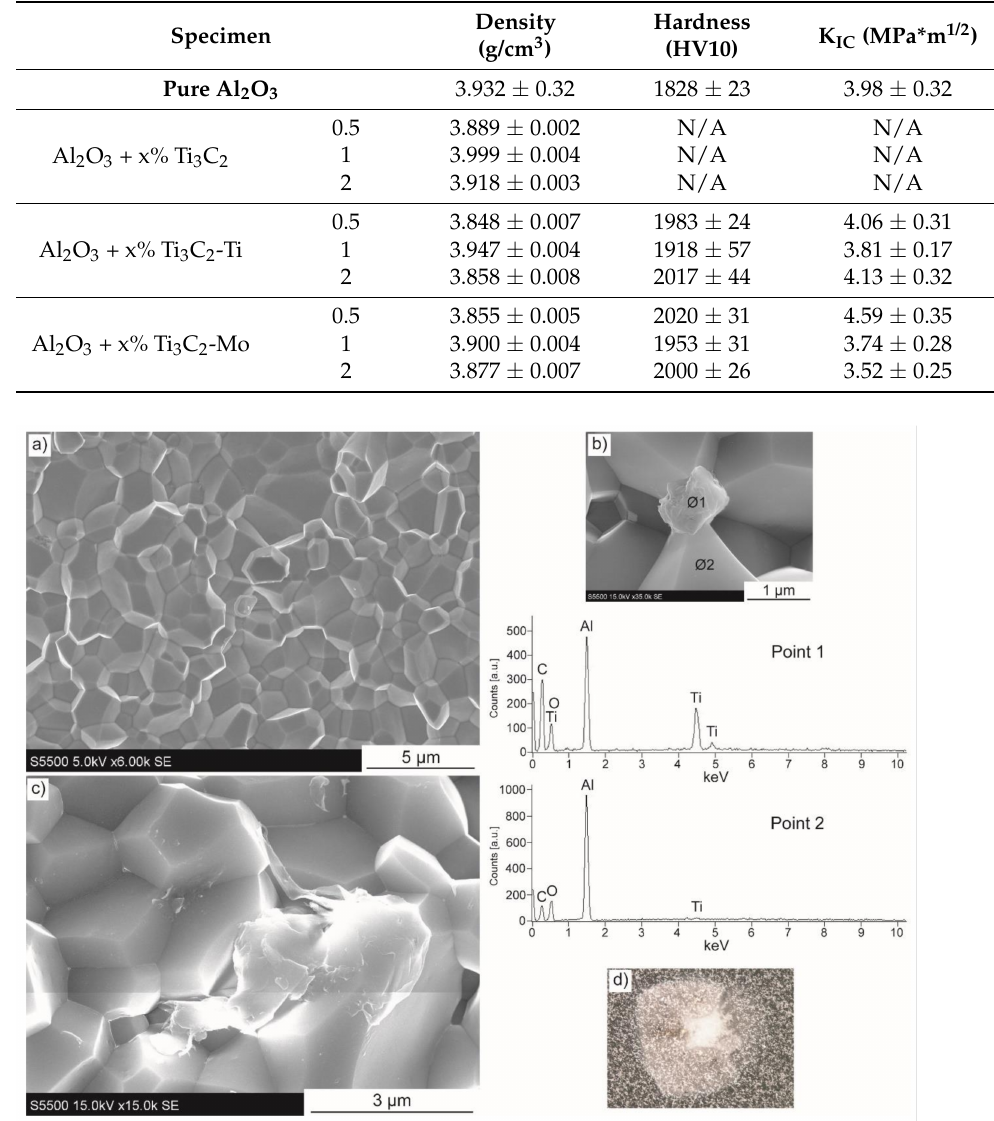
Table 1. Sinters density and mechanical properties.